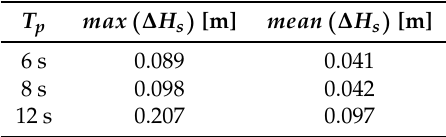
Table 3. Difference in wave height, ∆ H s = H s , SNL − H s , LWIT , over the nearshore